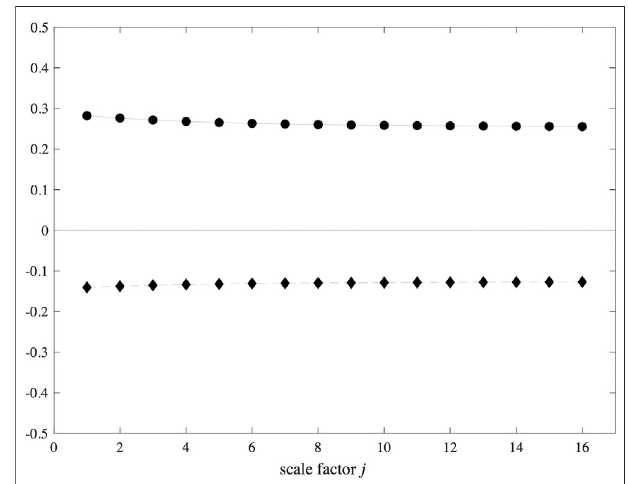
FIGURE 3 | Left: correlations of angle operator A 42 , 43 with A 23 , 24 (top, positive) and A 34 , 35 (bottom, negative). The same plot represents the correlations of A 41 , 45 with A 14 , 15 (top, positive) and A 54 , 53 (bottom, negative).